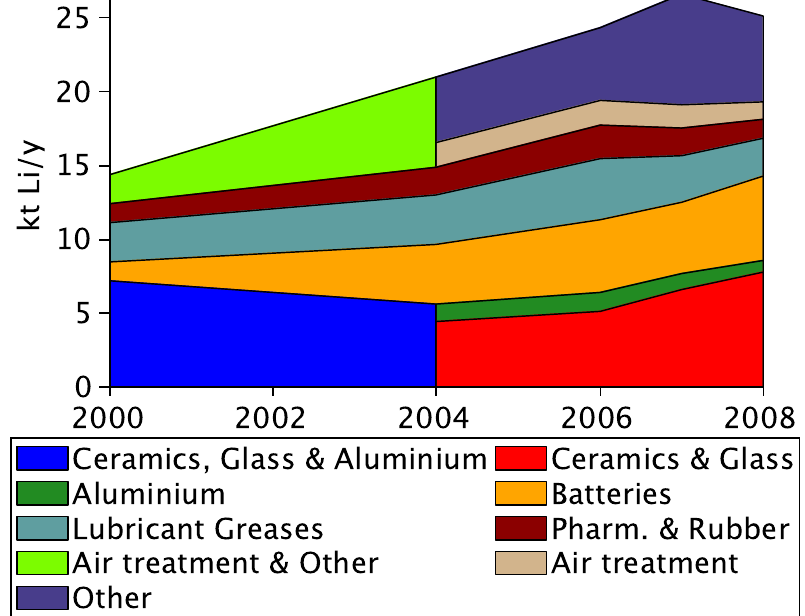
Figure 2. Recent world consumption of lithium, based on percent of uses (note: values prior to 2000 could not be found in the literature; reporting of consumption became more detailed in 2004)